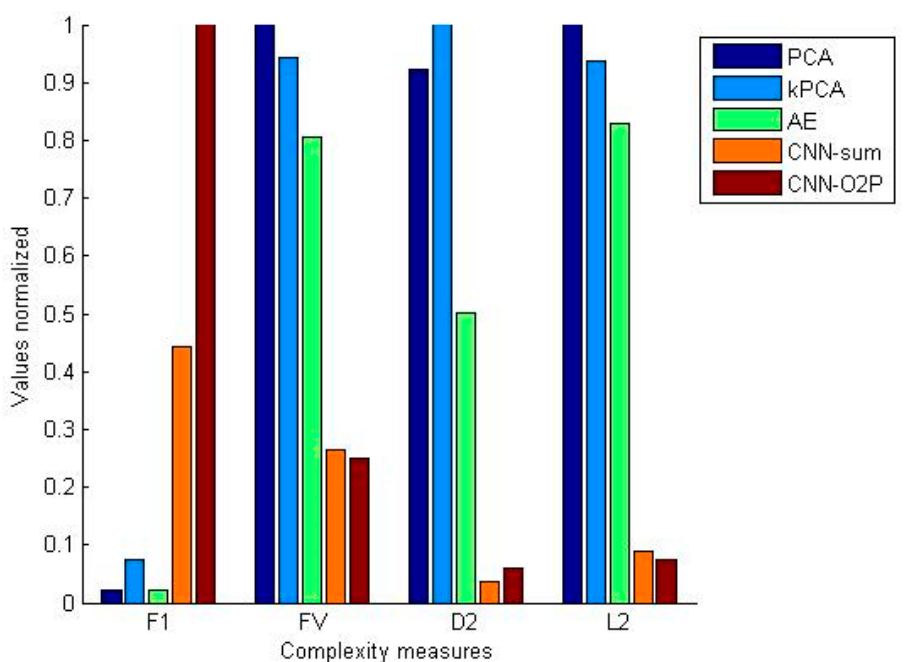
Figure 3. Plot comparing the complexity measures obtained in PCA, kPCA, AE, CNN-sum, and CNN-O2P from RealPatch. For ease of comparison, each of the complexity values measured was adjusted so that the maximum value was 1. In addition, CNN-sum and CNN-O2P were clearly compared only in F1. Thus, to clarify the focus of the paper, the two were analyzed only with a CNN.